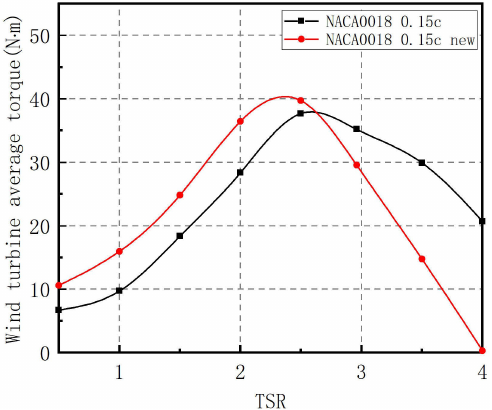
Figure 34. Variation curve of average torque with tip speed ratio before and after